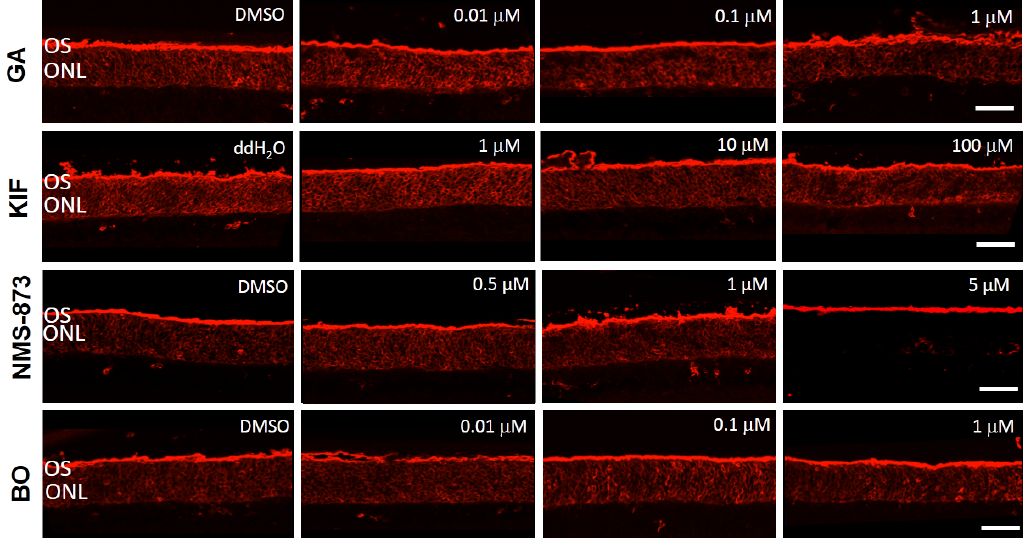
Figure 6. Only VCP inhibition mainly restores rhodopsin (RHO) localization to the outer segment (OS) in RHO P23H transgenic rat retinae in vitro. Fluorescent labeling in cryosections designates the location of RHO (red staining) in RHO P23H retinae organotypic cultures at PN15, explanted at postnatal day 9 and cultivated for 6 days (PN9 DIV6), treated with corresponding vehicle (ddH 2 O or DMSO) or different concentrations of Hsp90 inhibitor GA, ERM1 inhibitor KIF, VCP inhibitor NMS-873, and proteasome inhibitor BO. In the vehicle-treated groups, RHO distribution was observed with intense fluorescence staining in the ONL. Only in retinae treated with 5 µM NMS-873 is a reduction of the fluorescence in the ONL observed. Other inhibitors do not affect RHO distribution. Scale bar is 50 µm. OS: outer segment; ONL: outer nuclear layer; GA: geldanamycin; KIF: kifunensine; BO: bortezomib.